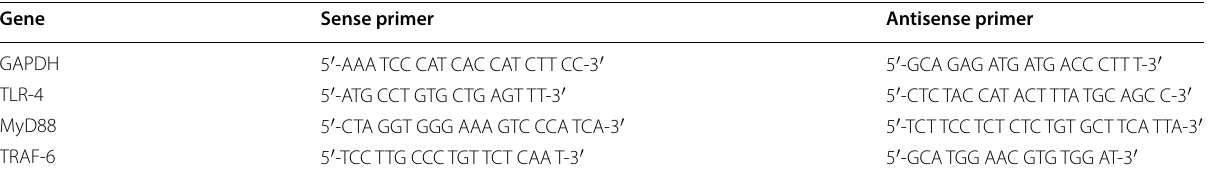
Table 3 PCR primer sequences used in this study Gene Sense primer Antisense primer